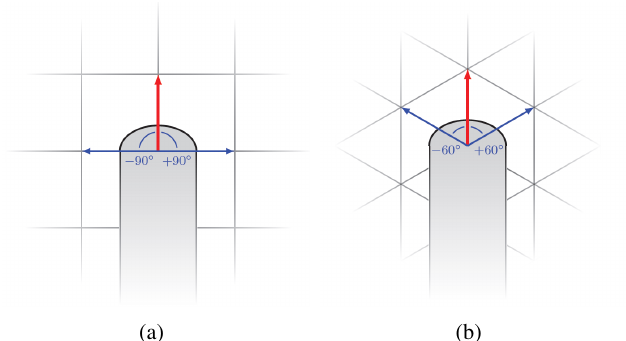
Fig. 1. The plane is discretized into elements of equal size. The elements can be square (left), allowing the hypha to change direction by 90 ◦ , or hexagonal (right), allowing a change of 60 ◦